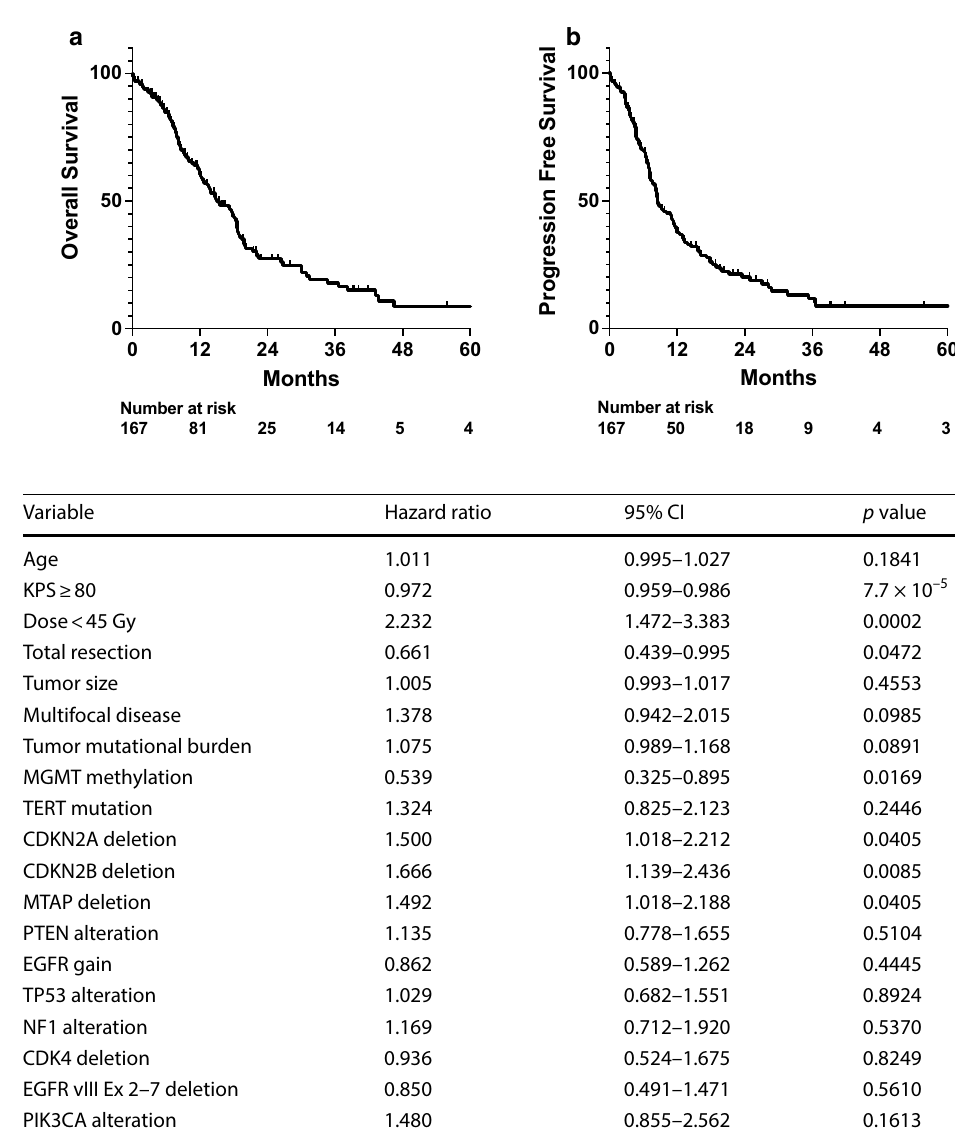
Table 2 Univariate analysis of impact of patient characteristics, treatments, and tumor genetics on OS in full patient